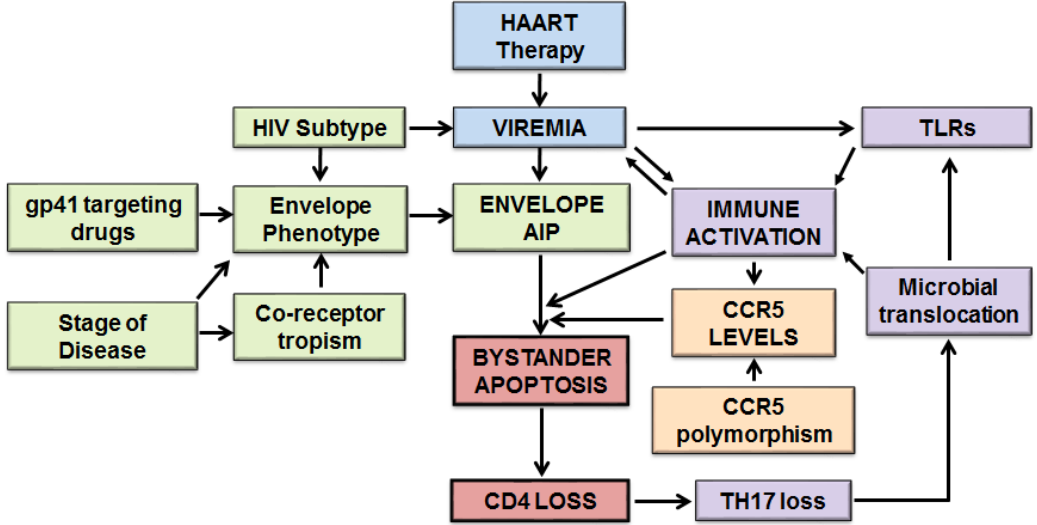
Figure 1. Model of host and viral factors in human immunodeficiency virus (HIV)-mediated bystander apoptosis. HIV mediated bystander apoptosis and CD4 decline can be attributed to both host and viral factors. Fundamental to this process is active virus replication (viremia) as suppressing virus replication via highly active anti-retroviral therapy (HAART) suppresses the major immunopathological variables of the disease including CD4 apoptosis and immune activation. The phenotype of the Envelope (Env) glycoprotein is another major determinant of HIV pathogenesis as the Env apoptosis inducing potential (AIP) correlates with CD4 loss. Other genotypic and phenotypic variations in Env like coreceptor usage, virus subtype, fusogenic activity of Env, etc. have been associated with disease. The binding of Env to CCR5 is also fundamental to HIV induced bystander apoptosis and variations in CCR5 levels can influence this phenomenon. Immune activation is a key immunopathological feature of HIV infections that correlates with CD4 decline and can be affected via multiple pathways as shown by arrows. TLR: toll-like receptor).